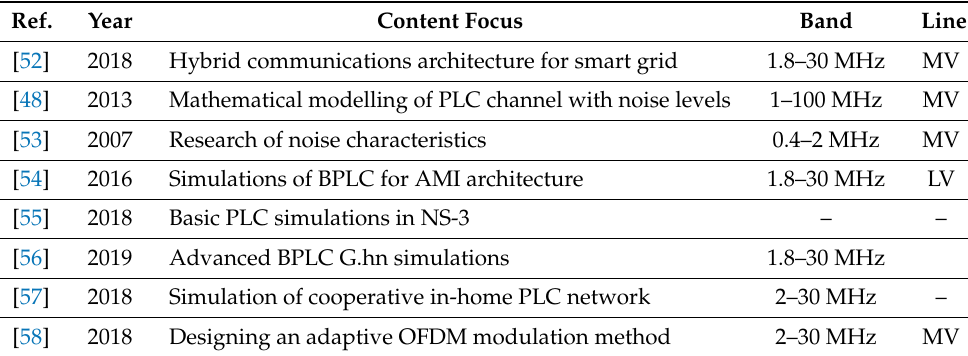
Table 3. Papers dealing with BPLC simulation with focus on frequency bands. Ref.